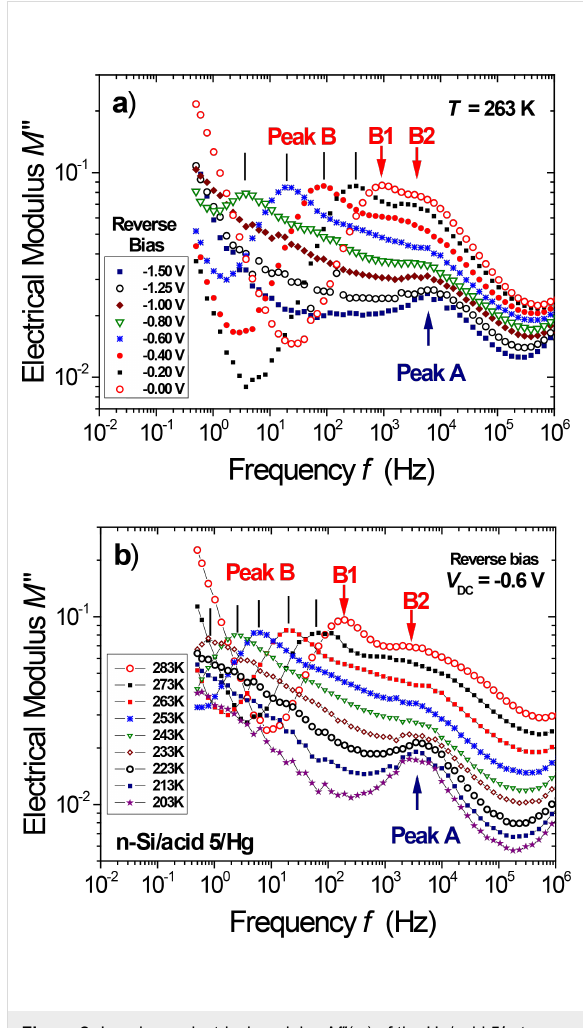
Figure 2: Imaginary electrical modulus M ″ ( ω ) of the Hg/acid 5 / n-type Si junction: a) reverse-bias dependence at T = 263 K; b) temperature dependence (203–283 K) under strong reverse bias ( V DC = − 0.6 V). The admittance data show (i) a bias-independent relaxation peak A ( f A ≈ 5 kHz) with a weak T dependence, and (ii) two bias-dependent peaks (B1 and B2) at lower frequency with strong bias and tempera- ture